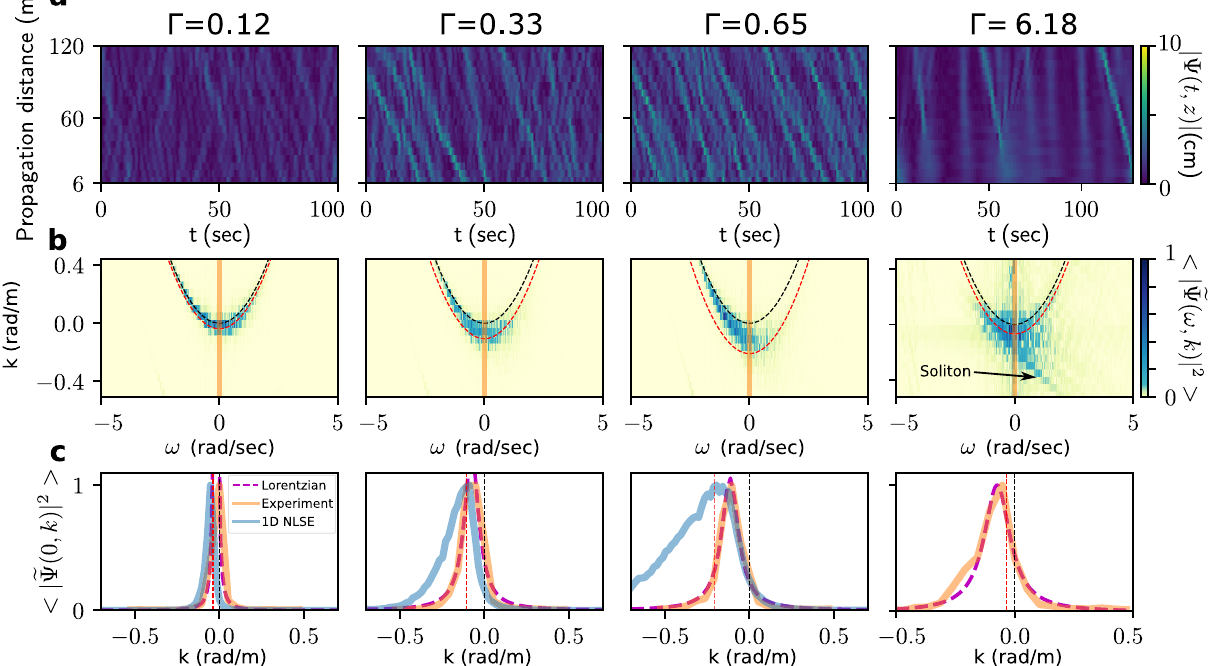
Figure 3. Experimental reconstruction of the nonlinear dispersion relation. Four columns correspond to four different values of Ŵ 0.12, 0.33, 0.65, and 6.18, respectively. (a) Spatiotemporal diagram of the wave �( t , z ) envelope amplitude . Data received from 20 probes have been post-processed and arranged in 20 | | τ z / c g ). (b) Nonlinear dispersion relation reconstructed vertical rows subtracting waves’ group velocity ( t = − from the evolution of the complex wave envelope. Ŵ 0.12, 0.33, 0.65 correspond to an initial spectral width = 2 0.2 Hz and (cid:31) f ψ(ω , k ) is averaged over several realizations (see “Methods”). In order to observe the = �| | � 6.18 (corresponding to (cid:31) f signature of a single soliton, the NDR is not averaged for Ŵ = (cid:31) 0 . Dashed purple line shows a Lorentzian fit, blue line Cross-section of the nonlinear dispersion relation at ω = shows corresponding results of NLS simulation.